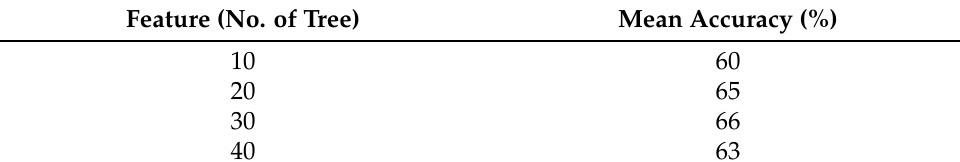
Figure 19. Haiti: Boxplot to illustrate the mean accuracy distribution by hyper-tuning the minimum number of samples per split. Table 9. Haiti: Predictive accuracy score against number of trees for each ensemble.